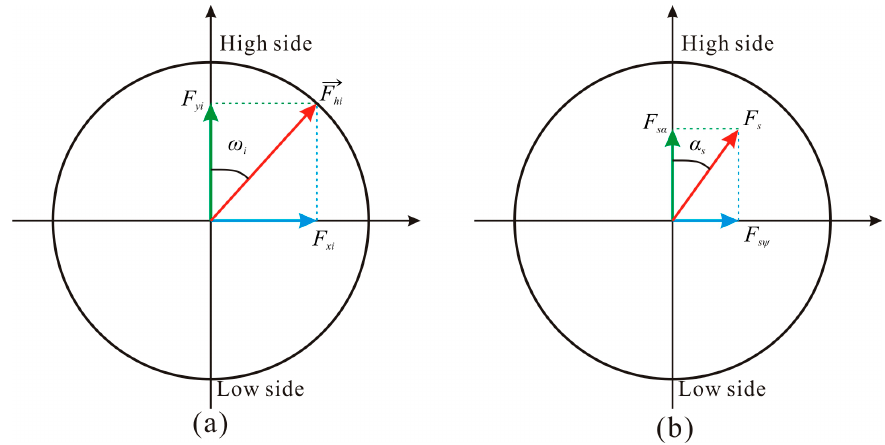
Figure 2. Sketch map of decomposition and synthesis of the side force analysis on the bit: ( a ) Decomposition for the vector of side force on the bit and ( b ) synthesis of the resultant steering force on the bit.